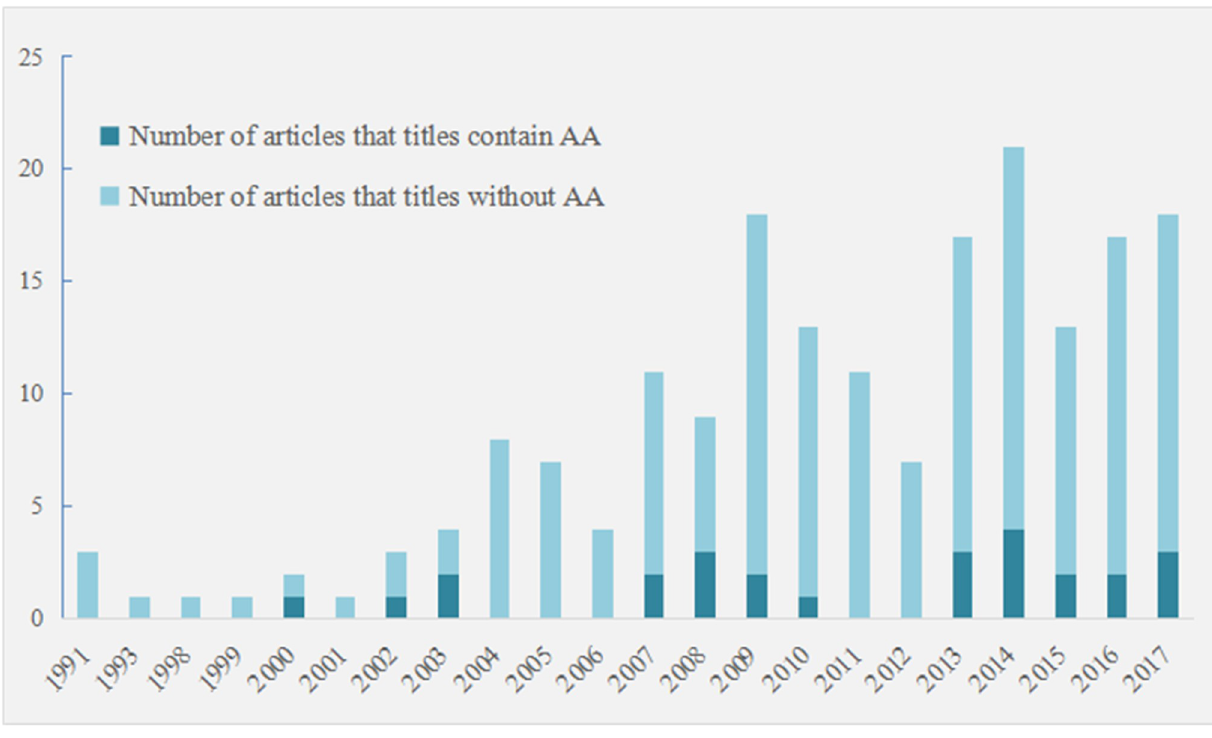
Fig 9. Number of AA-related review